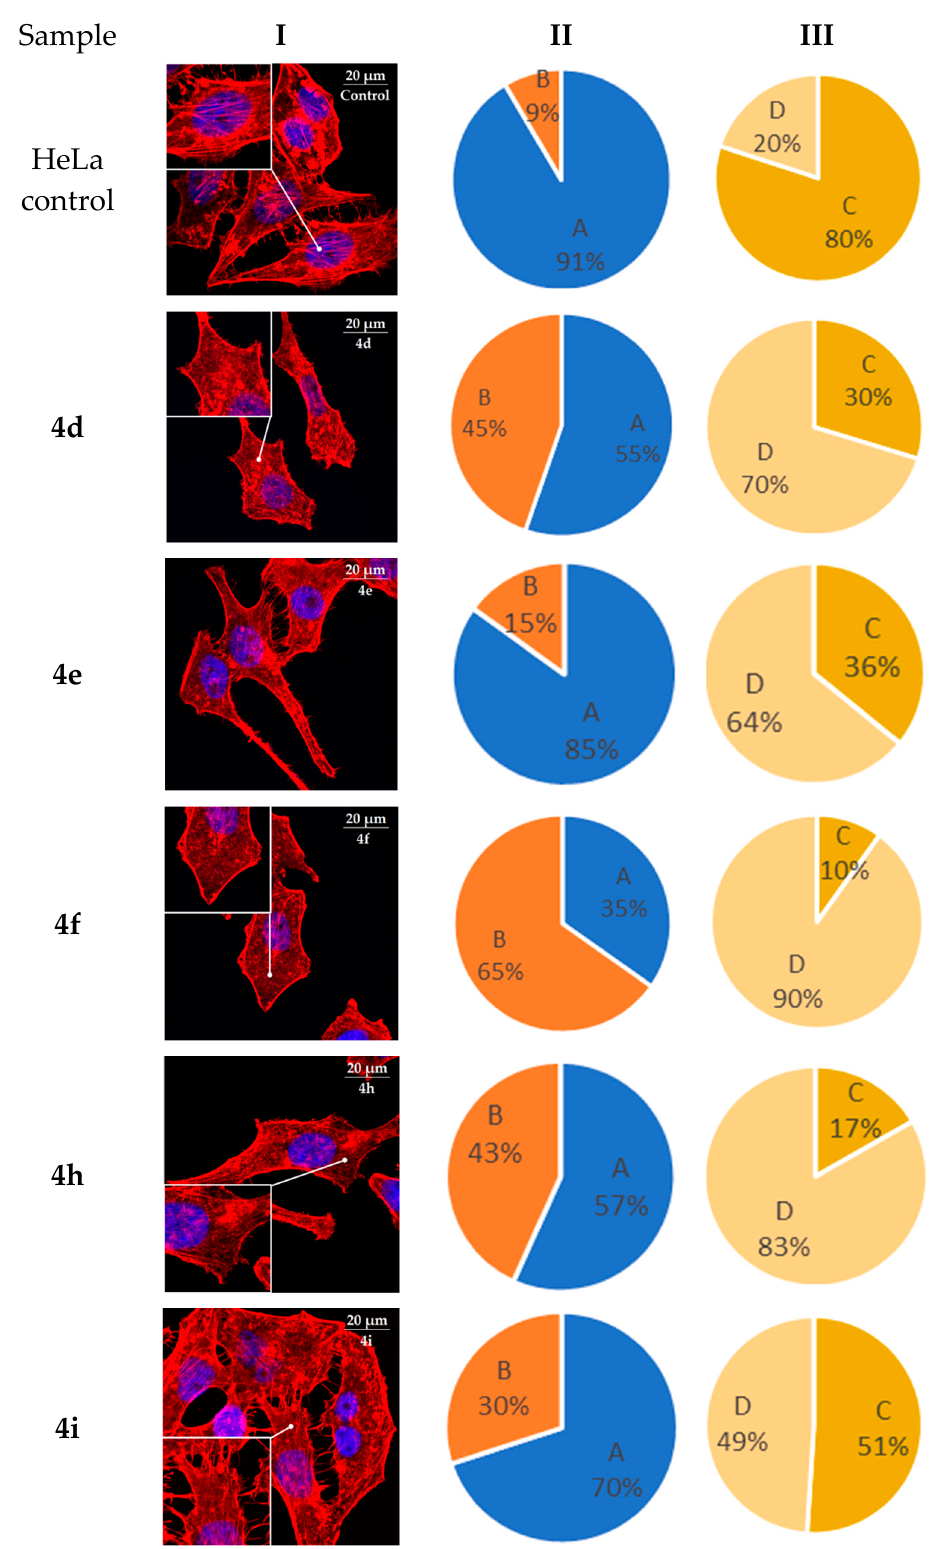
Figure 14. State of actin cytoskeleton of HeLa cells after treatment with 3-azaspiro[bicyclo[3.1.0]hexane-2,5 ′ -pyrimidines] 4d , 4e , 4f , 4h , and 4i . I: Images demonstrate the different stages of cell actin cytoskeleton. II: Pie charts demonstrate percentage of cells with filopodia-like deformations (A) and without filopodia-like deformations (B). III: Pie charts demonstrate percentage of cells with normal stress fibers (C) and disassembled stress fibers (D).